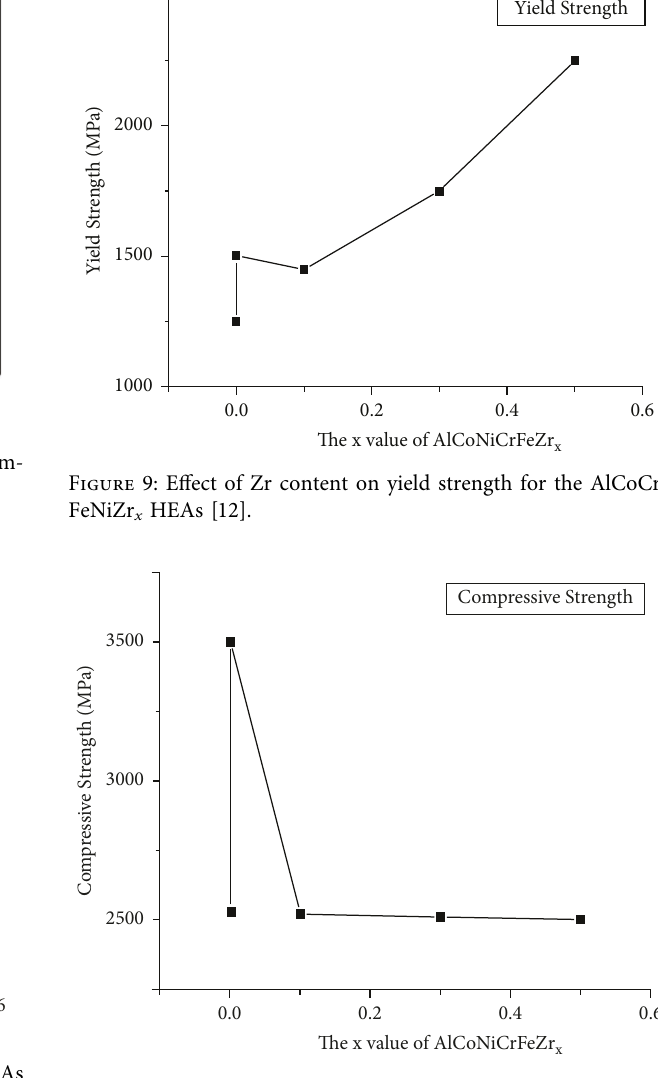
Figure 10: Influence of Zr content on compressive strength for the x HEAs AlCoCrFeNiZr x HEAs